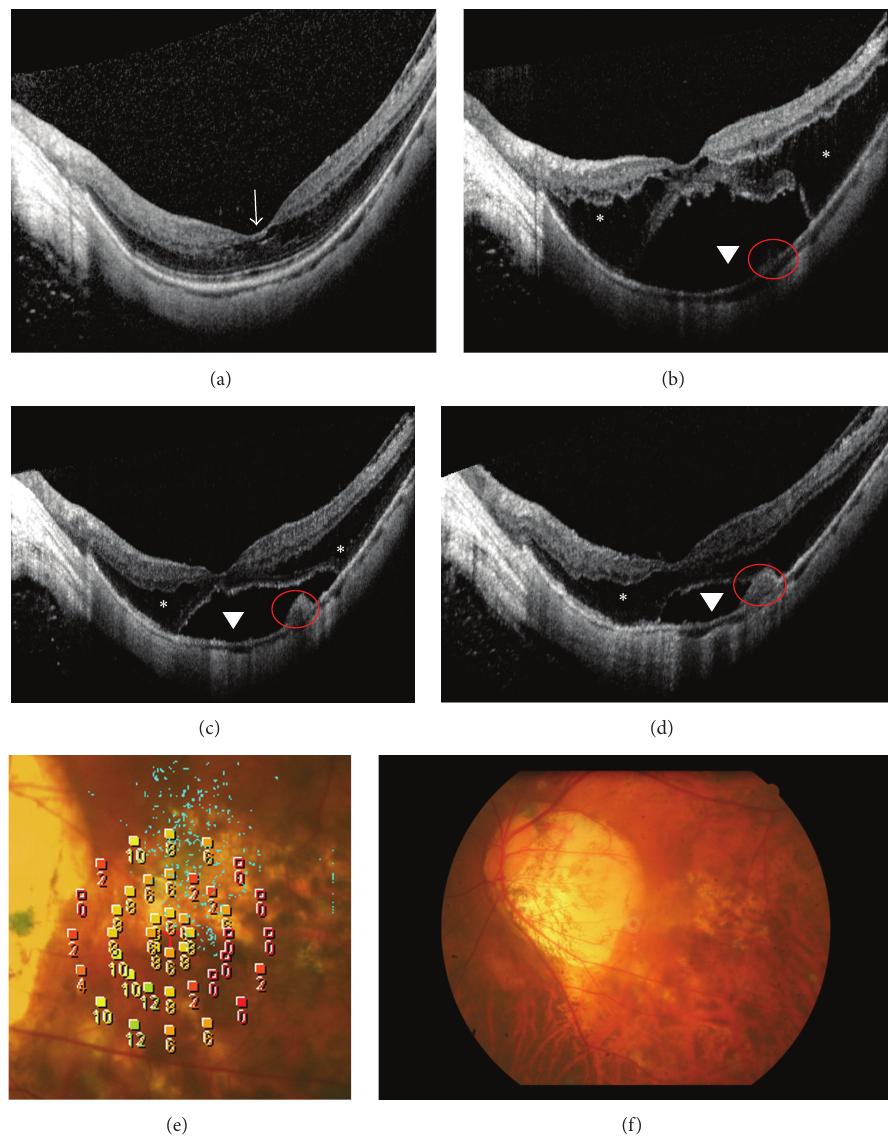
Figure 5: OCT findings in Case 4 during follow-up. (a) Baseline OCT reveals mild macular retinoschisis (arrow). (b) At 19 months, OCT reveals progression of myopic maculopathy with foveal detachment (arrowhead), retinoschisis (asterisk), and CNV (red circle) evident. (c) At 28 months, OCT reveals improvement in retinoschisis and foveal detachment. (d) At 39 months, OCT reveals further improvement. (e) At 39 months, microperimetric image reveals that retinal sensitivity was 5.10 dB and with unstable fixation. (f) At 39 months, fundus photograph depicts some atrophy in the central